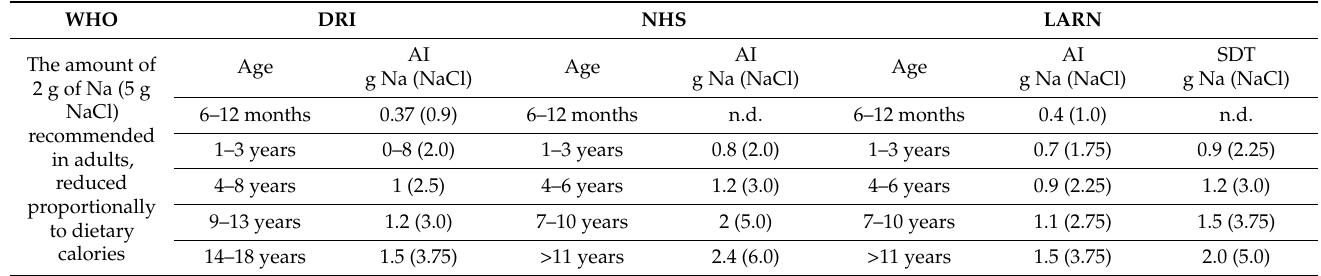
Table 1. Recommended intake of sodium and salt in children and adolescents.